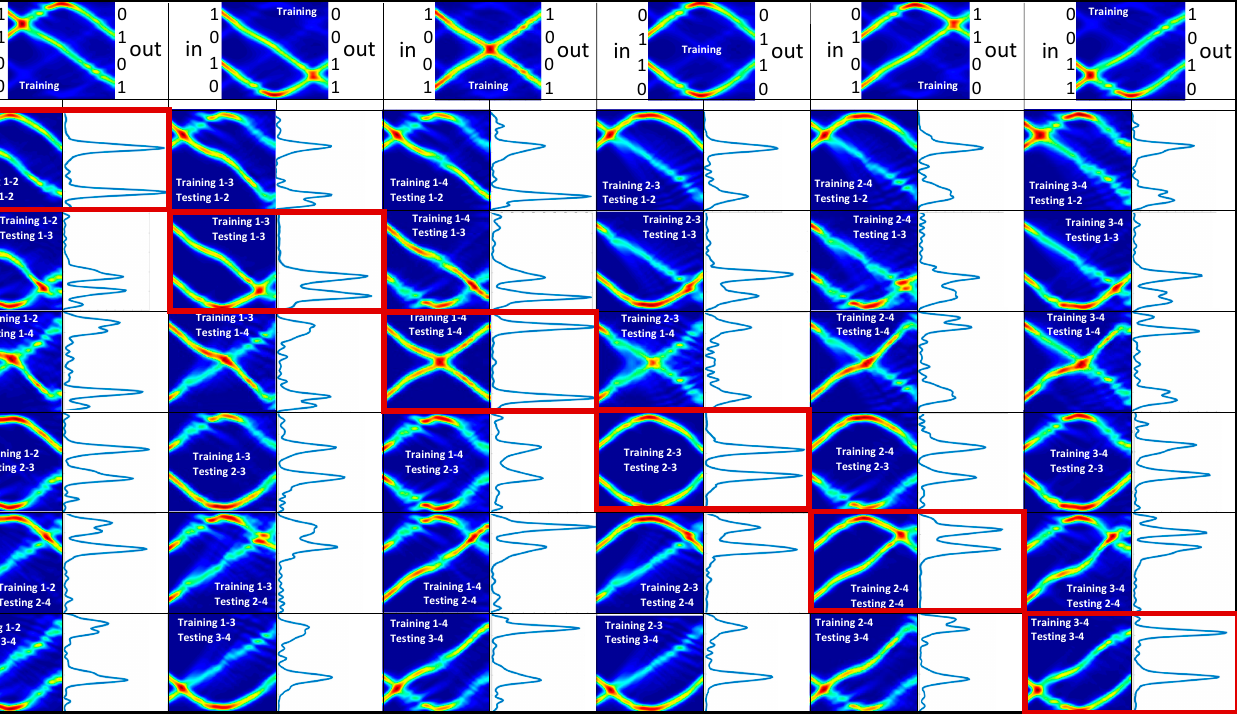
Figure 12. Amplitudes of the output signals for the different training 2-digit, 4-bit numbers. As shown, for each training number, there is only one case in which both outputs exceed the threshold (dashed horizontal line): ( a – f ) report the cases of validation after having trained the possible com- binations of channels respectively. However, the network is also able to recognize single-trained digits. 6.1.3. 3-Digit, 4-Bit Numbers The SNN network learning behavior has been studied also for the recognition of three illuminated pixels. The training procedure follows the scheme of the two cases previously described.